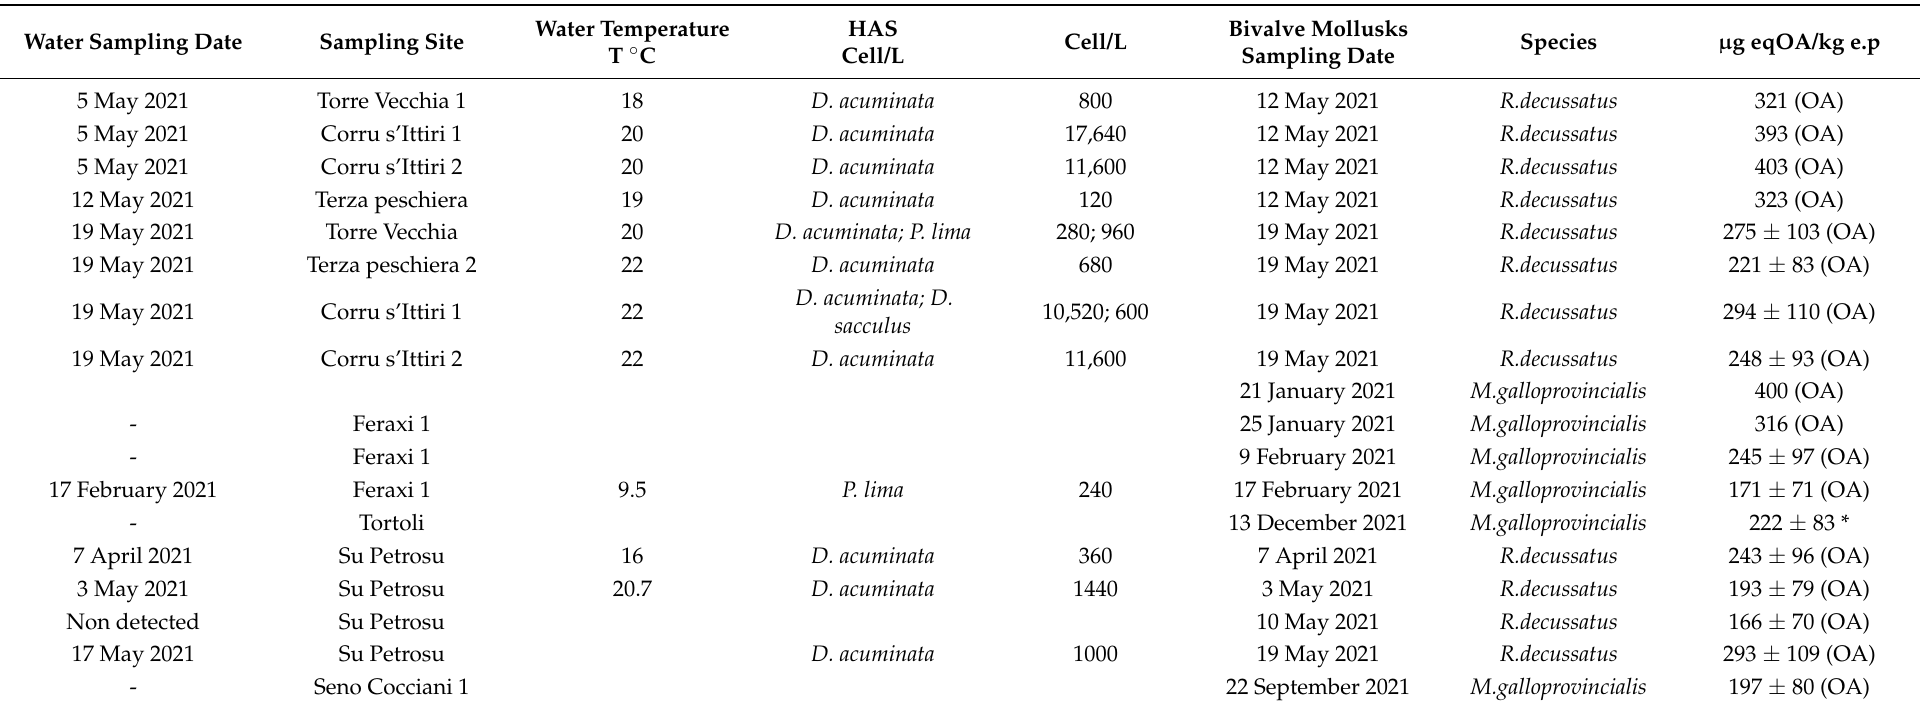
Table 3. Presence of algae belonging to the genus Dinophysis and Prorocentrum and samples with the concentration of OAs exceeding the limits of 160 µ g OA eq/kg